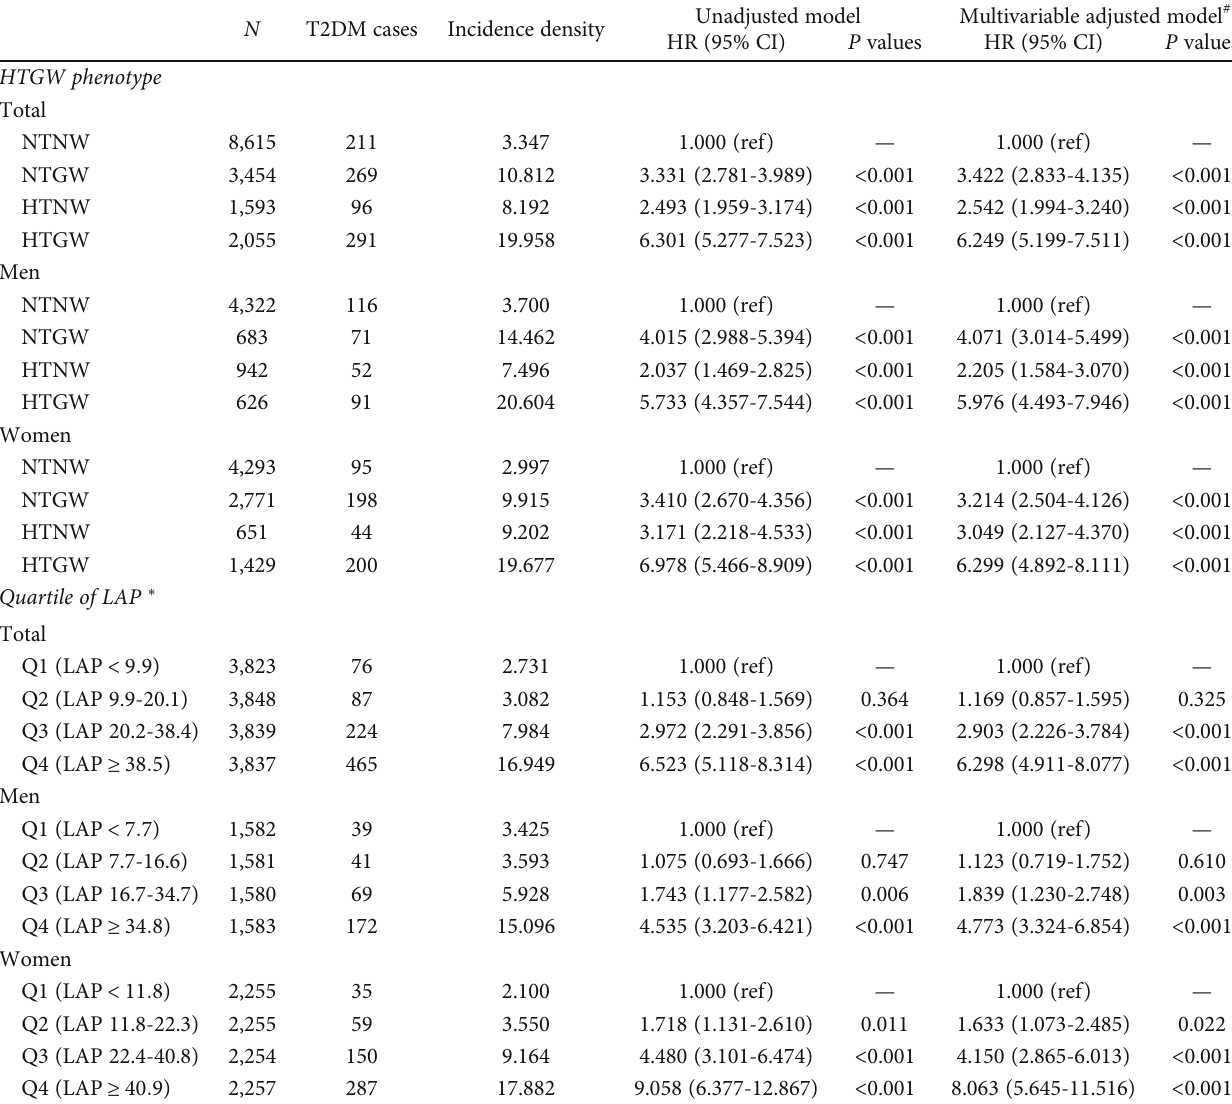
Table 2: Hazard ratios for the incidence of T2DM according to the four phenotype groups and quartile of LAP.